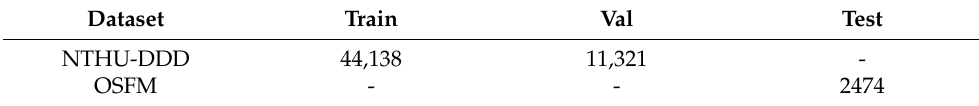
Table 1. Train and test sample